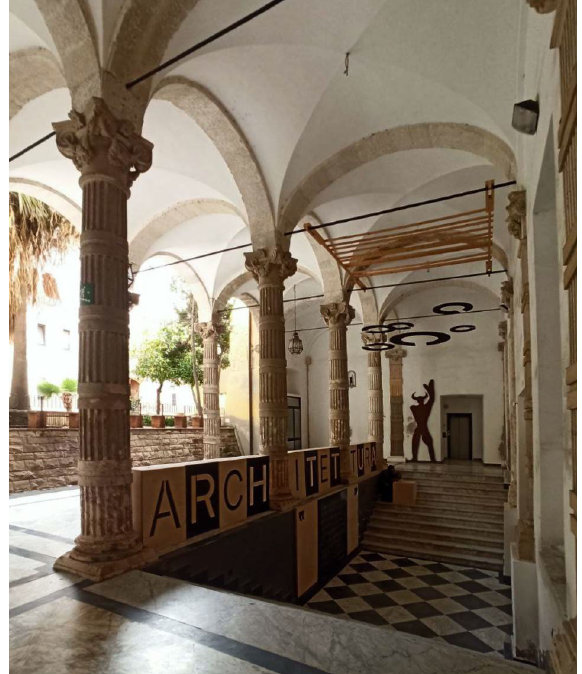
Figure 2 . The entrance hall of the former Jesuit College of Santa Croce in Cagliari, today seat of the School of Architecture of the University of